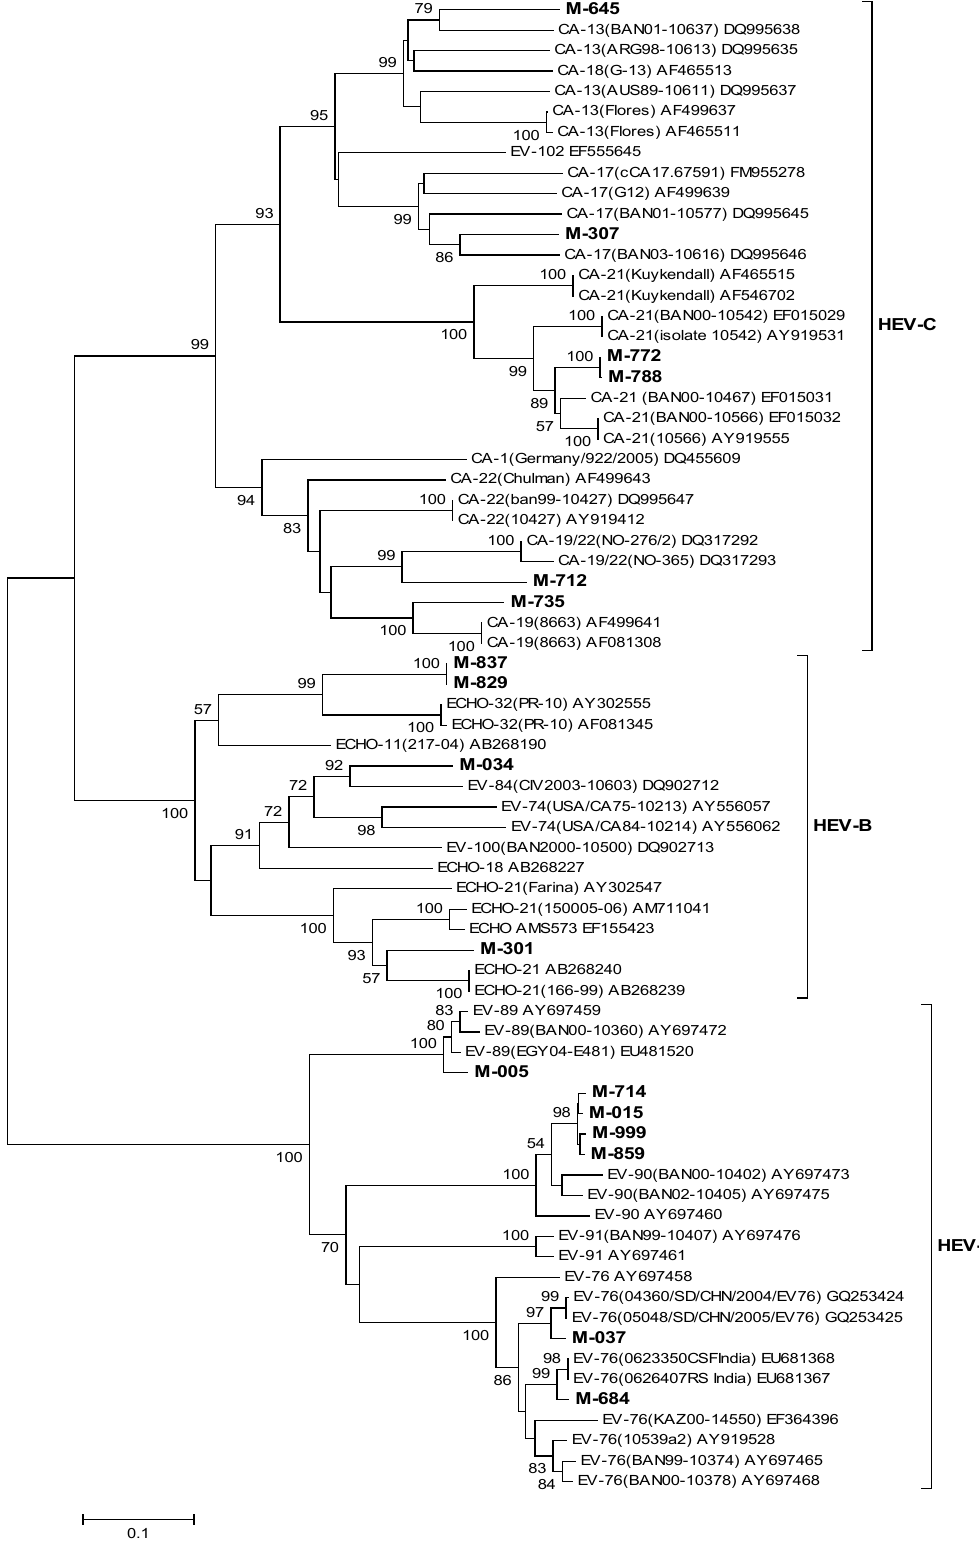
Figure 7. Phylogenetic tree based on the partial nucleotide sequences of VP1/2A gene (363 bp) of EV strains. The strains of the present study are in bold face. Scale indicates genetic distance. * Human